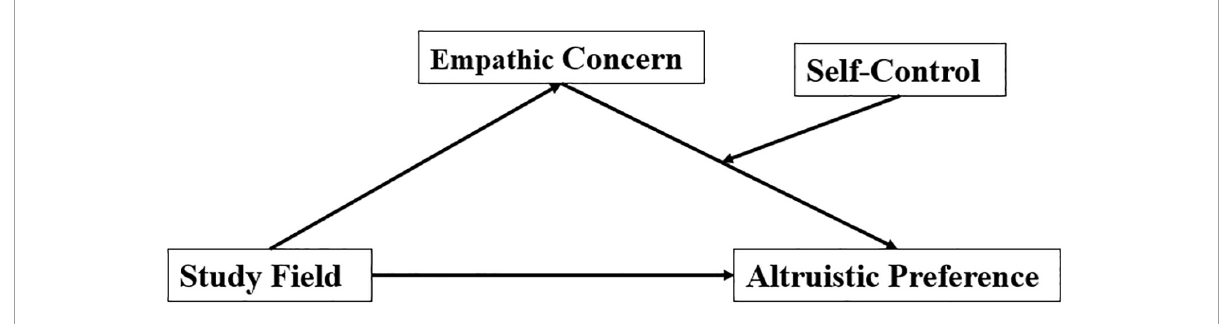
FIGURE1 The proposed theoretical model.